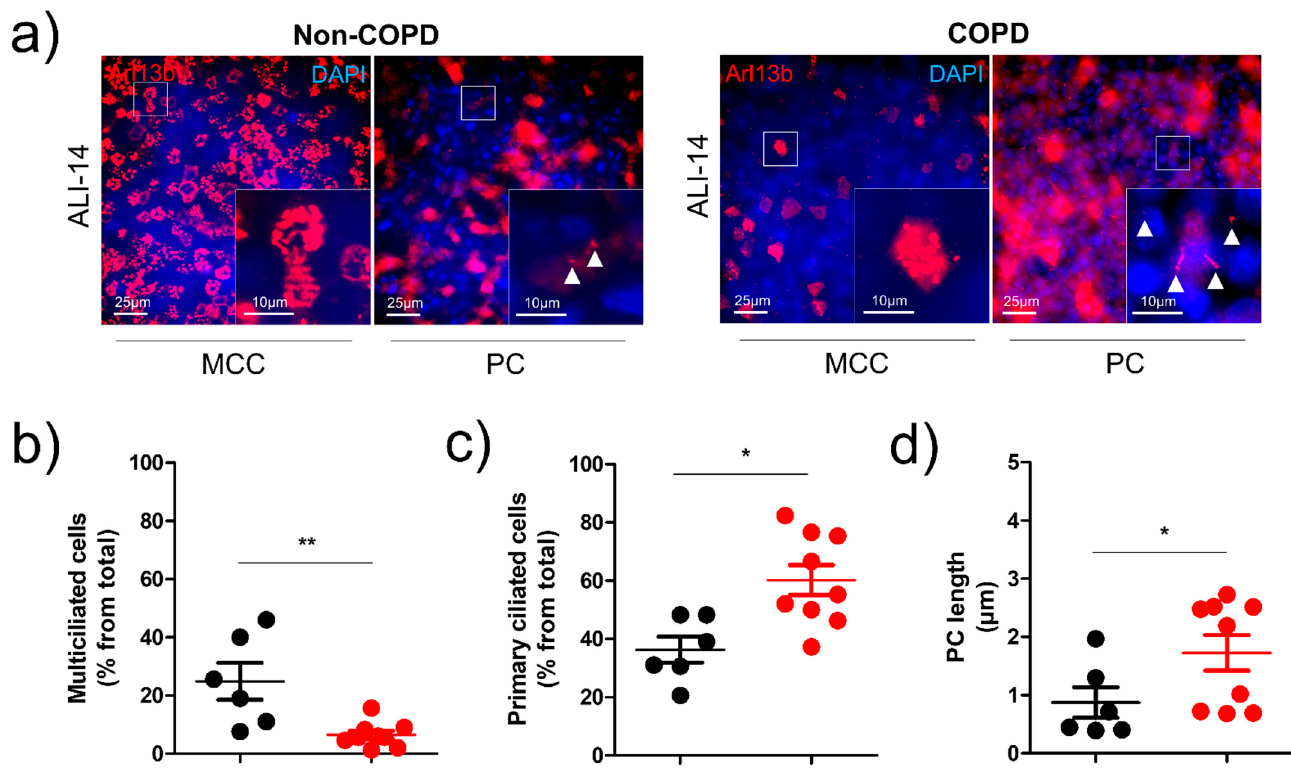
Figure 3. Primary ciliogenesis is altered in COPD-derived AEC ALI cultures. ( a ) Examples of micrographs taken from AEC cultures from non-COPD and COPD patients at ALI-14 showing motile cilia and primary cilia (Arl13b, red). Nuclei are stained in blue (DAPI). Magnification corresponding to the selected area is shown. White arrowheads indicate primary cilia. Dot plot (mean +/ − SD) represents the percentage of MCC ( b ), the percentage of primary ciliated cells ( c ), and the length of PC ( d ) at ALI-14 in non-COPD AEC-derived ALI cultures (black, n = 6) and COPD AEC-derived ALI cultures (red, n = 8). * p < 0.05, ** p < 0.01 non-COPD vs. COPD.